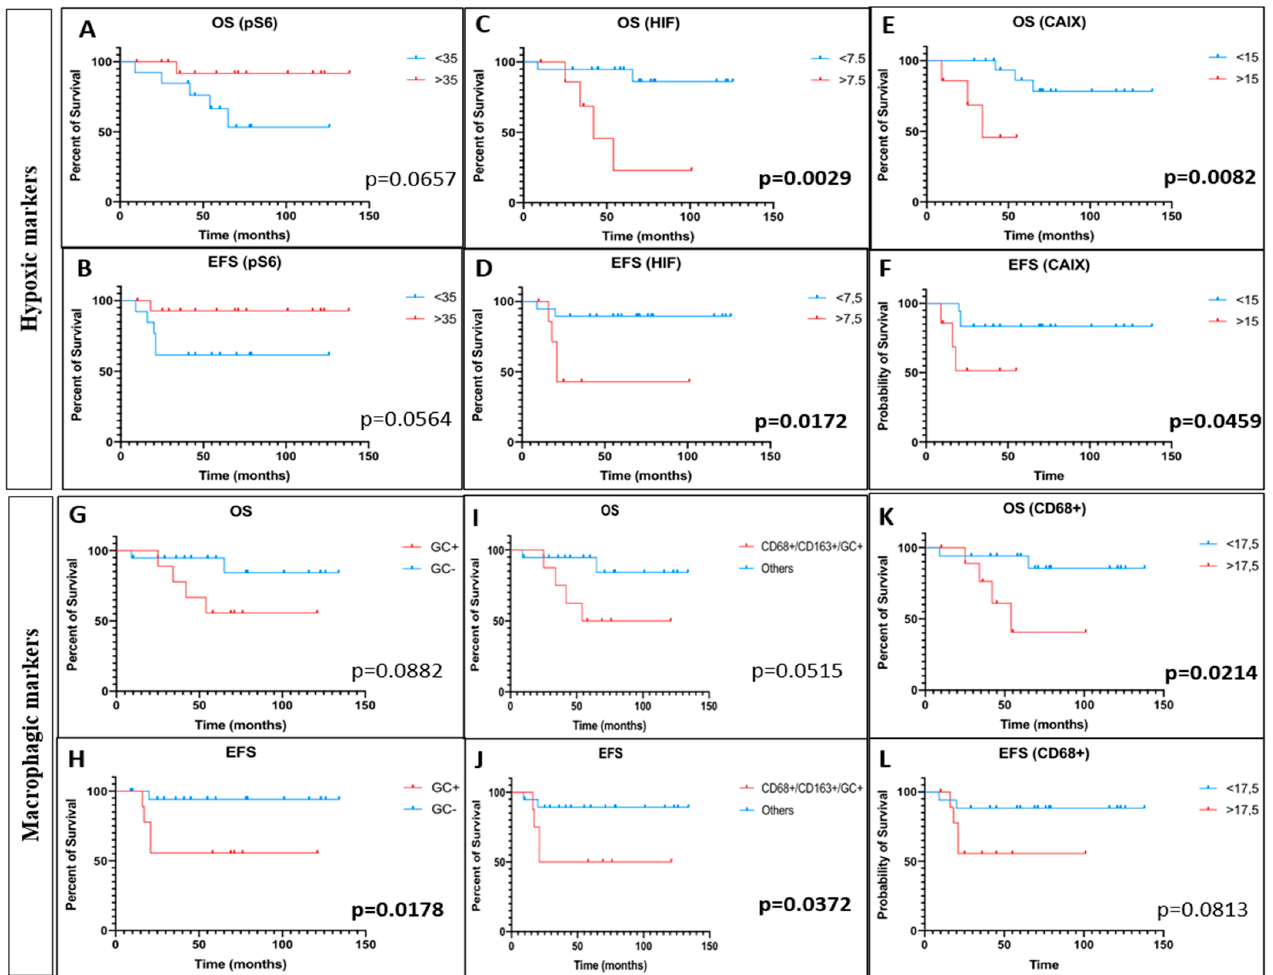
Figure 6. Kaplan–Meier significant correlations with immunohistological analyses of hypoxic and macrophagic biomarkers. On the upper rows, Kaplan–Meier estimates curves of OS and EFS according to the expression of pS6-RP (pS6) (( A ) and ( B ), respectively), HIF-1 α (HIF) ( C ) and ( D ), respectively) and carbonic anhydrase IX (CAIX) (( E ) and ( F ), respectively). On the two last rows, Kaplan–Meier estimates of OS ( G ) and EFS ( H ) by the presence or absence of intra-tumor giant cells (GC). We stratified the population with three biomarkers associating CD68, CD163 and GC presence to a worse OS and EFS (( I , J ) curves). Finally, OS and EFS distributions based on the expression of CD68 based on the cutpoint of 17.5% expression (( K , L ) graphs, respectively). p values are reported on the right corner of the graphs, in bold when p < 0.05.